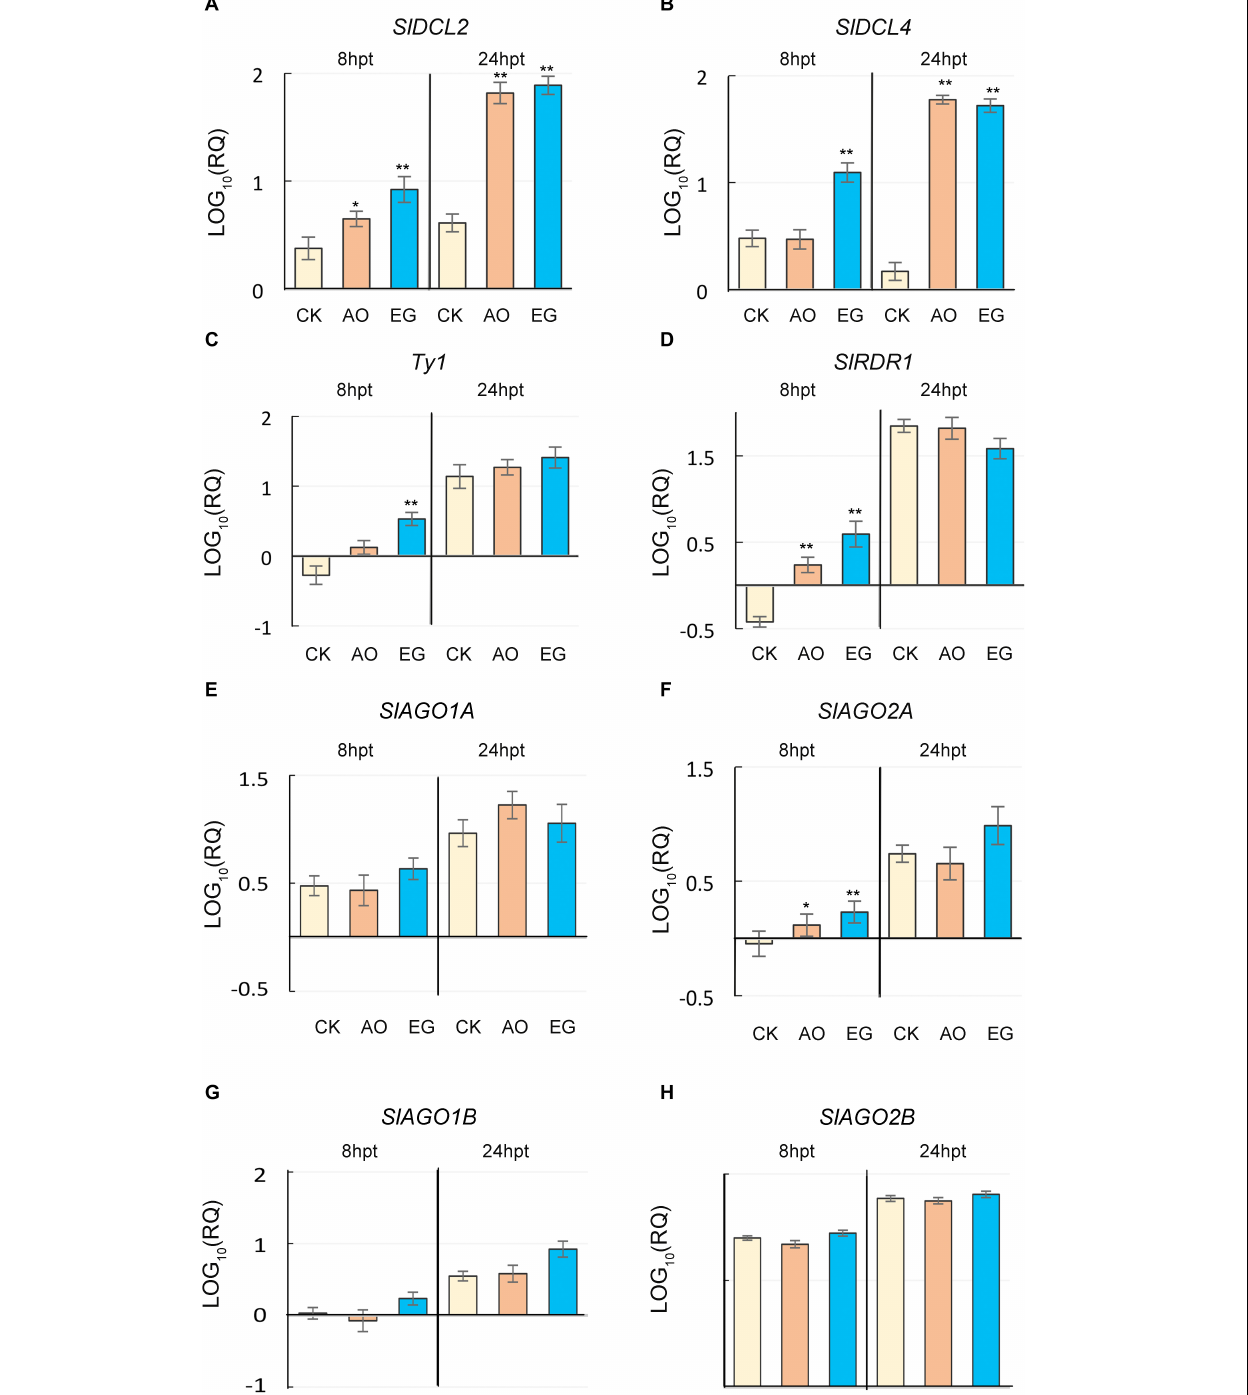
Frontiers in Plant Science |